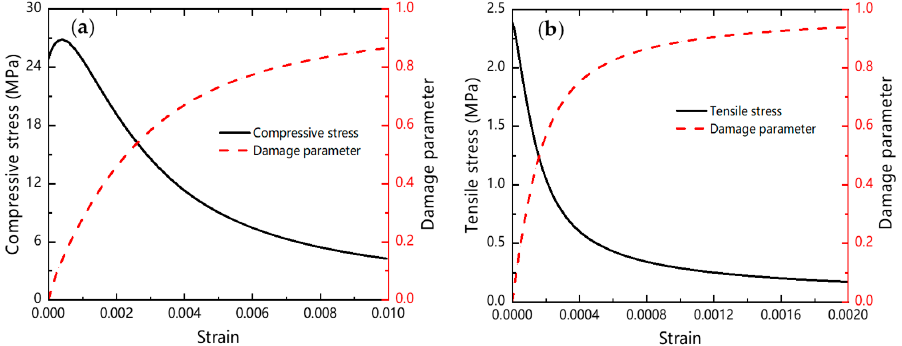
Figure 4. Stress–strain curve and damaged plasticity for a typical concrete cube under ( a ) compressive and ( b ) tensile loadings.